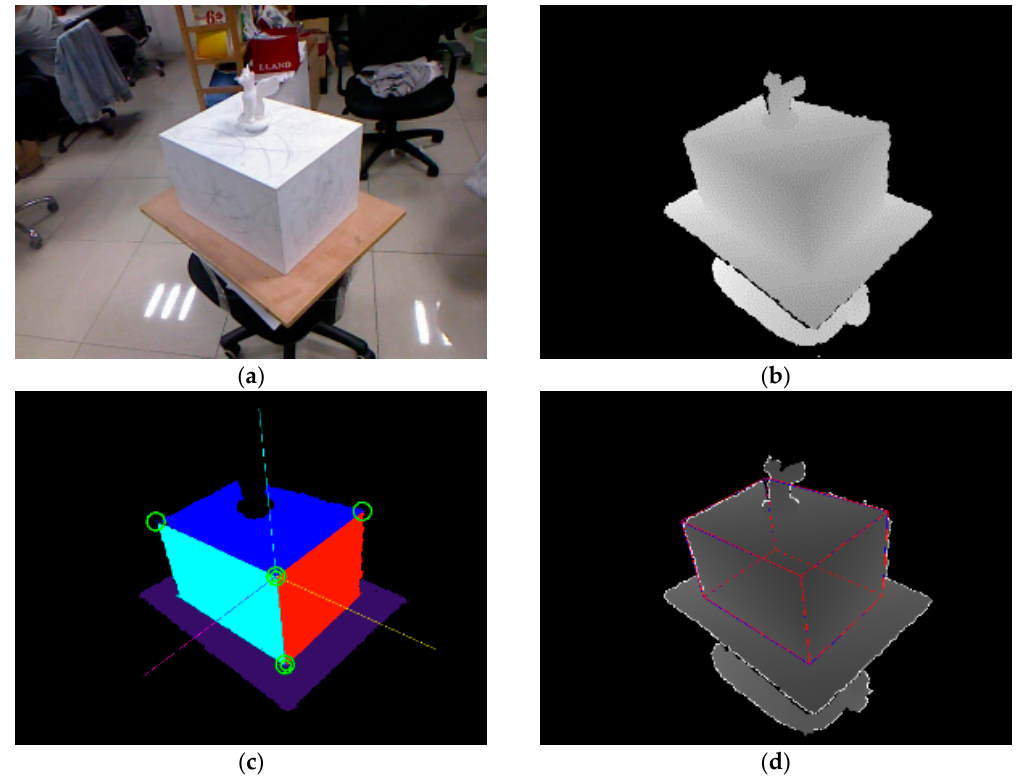
Figure 3. ( a ) Color (not used) and ( b ) depth image from our input sequence “wingedcat;” pixels with depth values larger than 1.5 m are truncated in the depth image; ( c ) Segmented planes obtained by the AHC algorithm [38] are labeled with random colors, the cuboid is localized with its vertices marked as green circles, and the axes of the cuboid frame are drawn in CMY colors; ( d ) The localized cuboid is drawn as a red wireframe in the depth image, and the “contour generators” proposed in [23] are drawn as white lines.